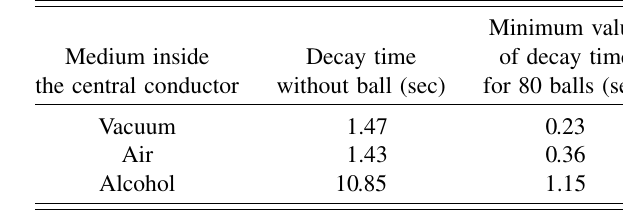
TABLE I. Minimum decay time in three different